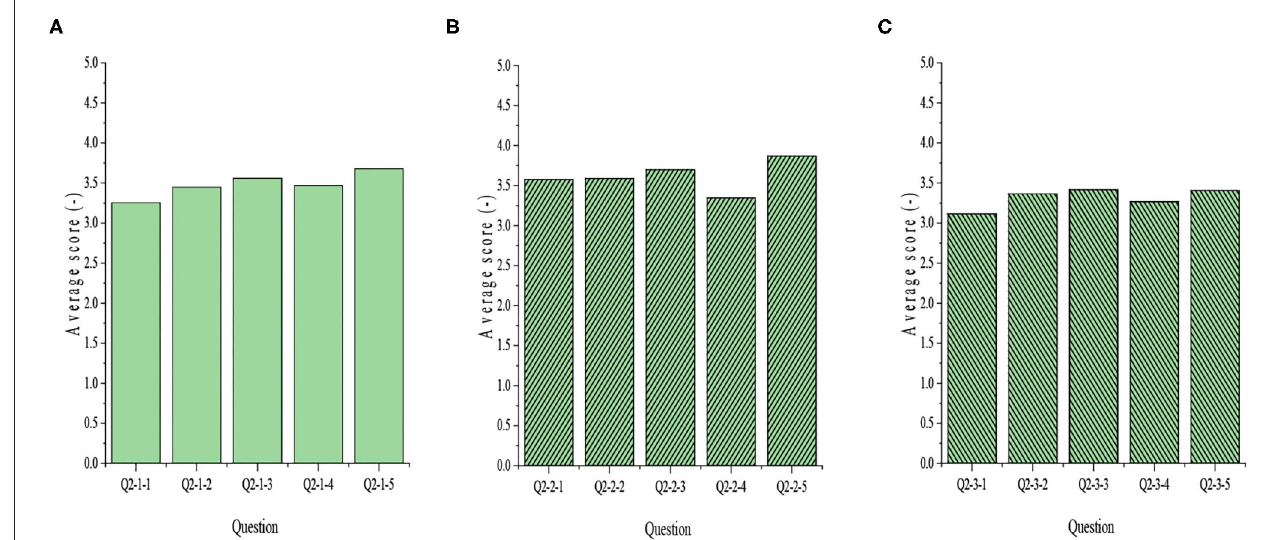
FIGURE 7 | Analysis on innovation behavior of college-student entrepreneurs during work.